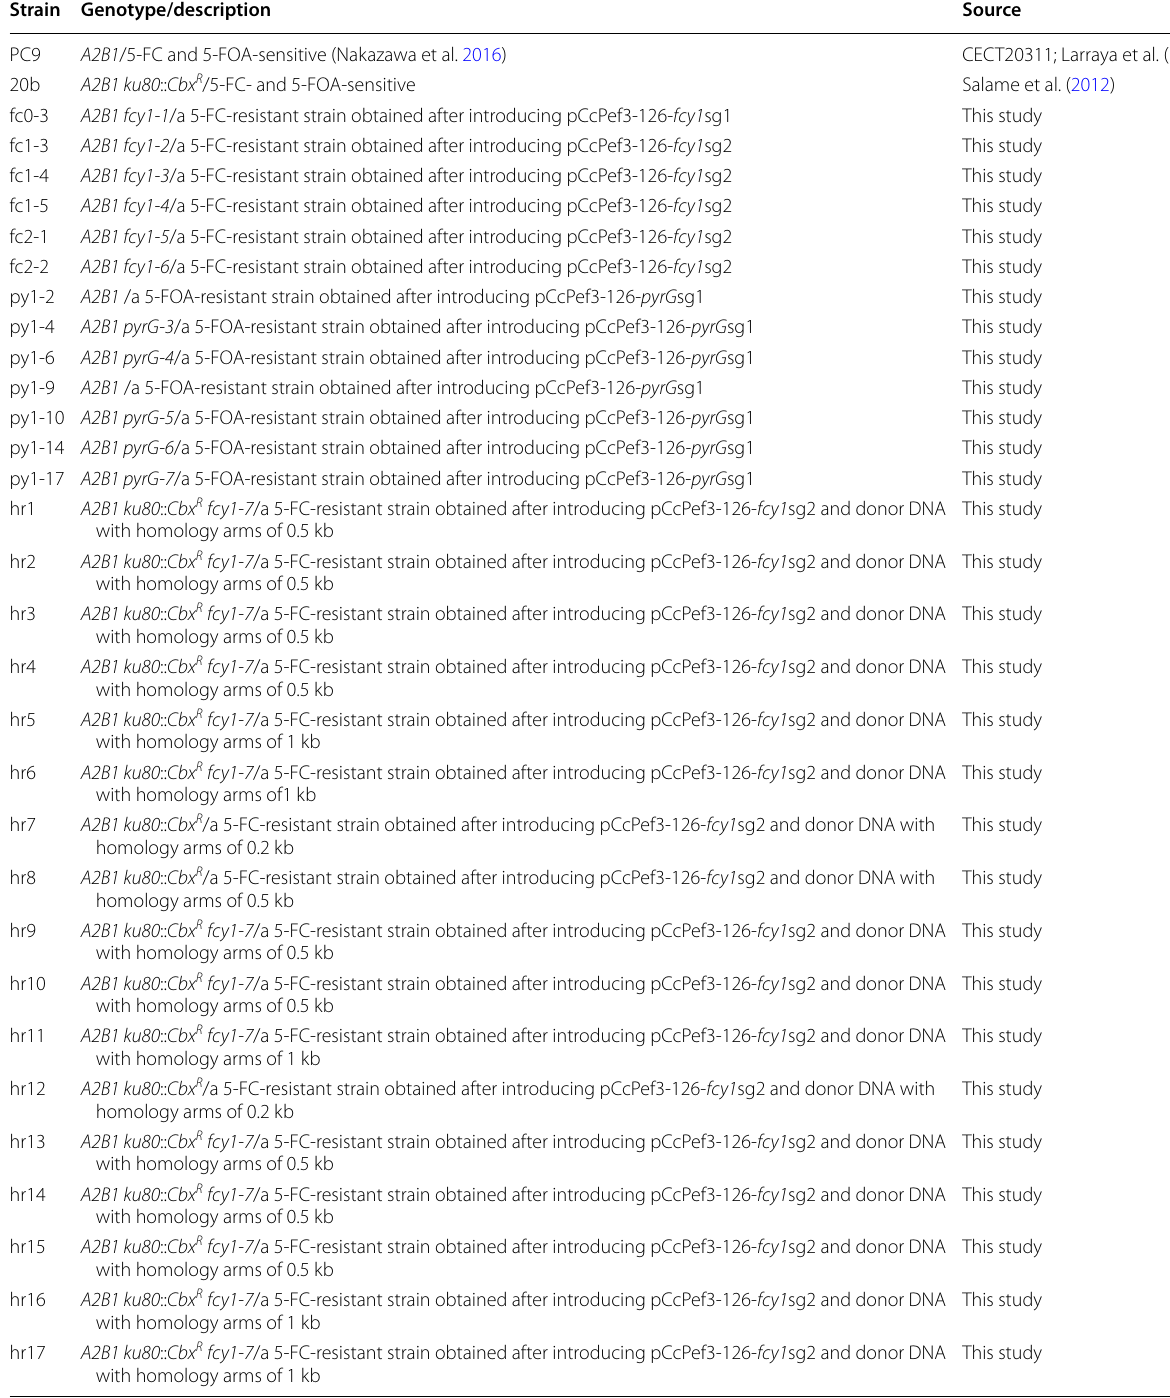
Table 1 P. ostreatus strains used in this study Strain Genotype/description Source